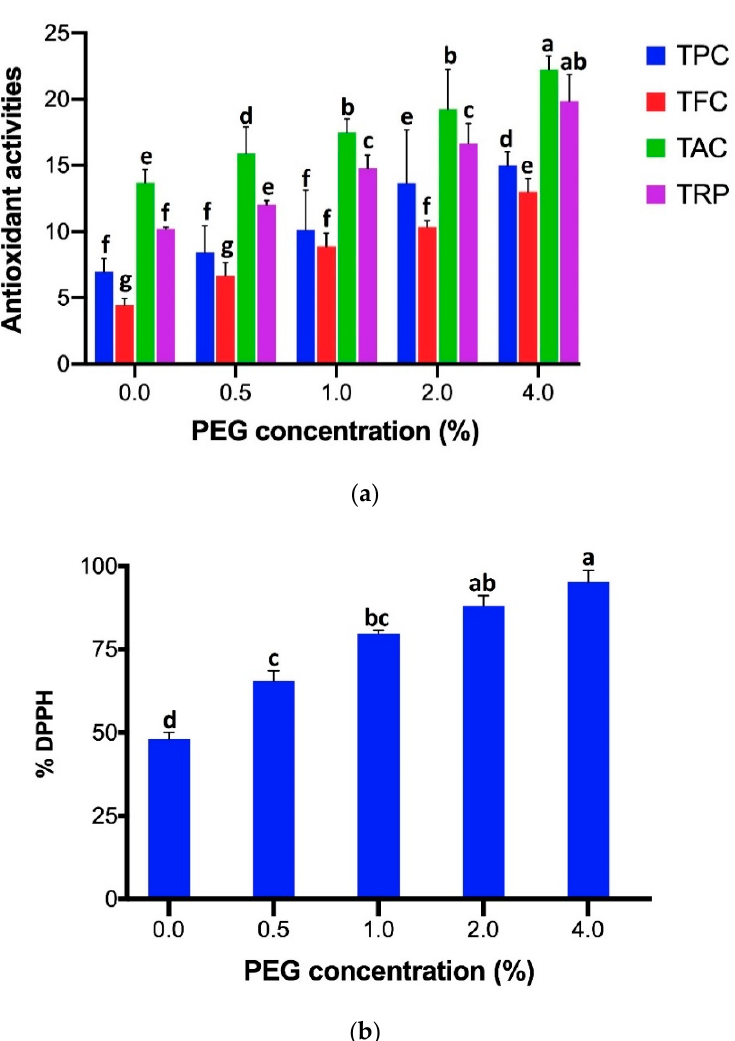
Figure 2. ( a ) Comparison of antioxidant activities (TPC, TFC, TAC, TRP) results expression for each assay of shoots grown under different PEG 6000 concentrations (0, 0.5, 1, 2, 4%). For each parameter, bars with different case letters are significantly different at the confidence interval level of 95% (Duncan’s multiple range test). ( b ) Comparison of % DPPH-free radical scavenging activity of shoots grown under different PEG 6000 concentrations (0, 0.5, 1, 2, 4%). Bars with different case letters a – g are significantly different at the confidence interval level of 95% (Duncan’s multiple range test).